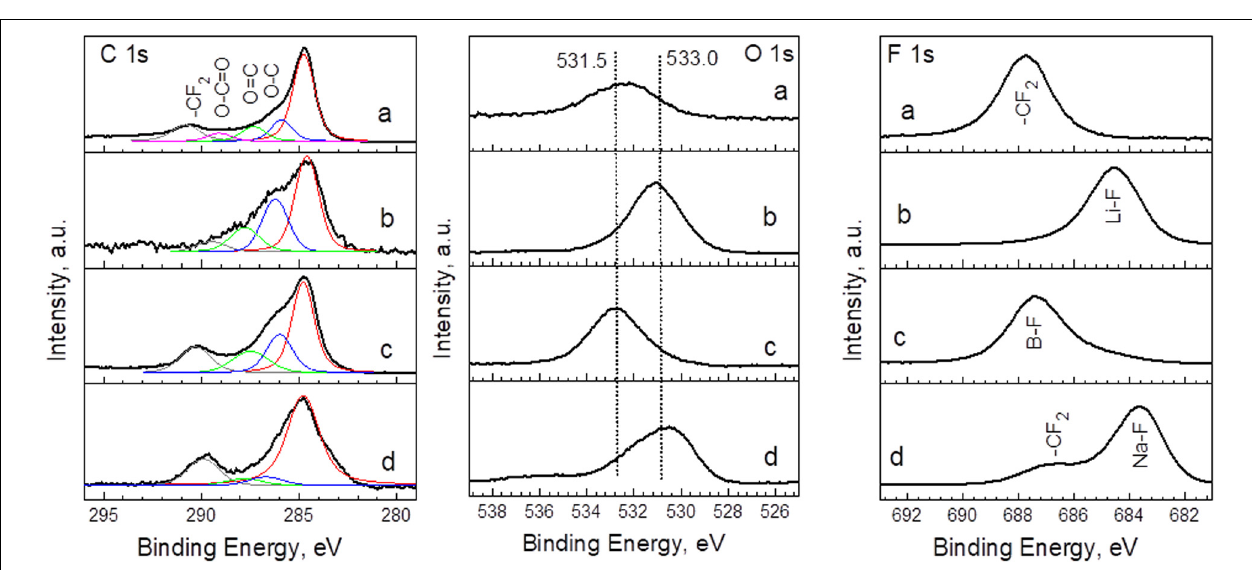
FIGURE 5 | C1s, O1s, and F1s spectra for pristine YP-50F (a) and YP-50F worked in LiPF 6 (b), LiBF 4 (c), and NaPF 6 (d) and